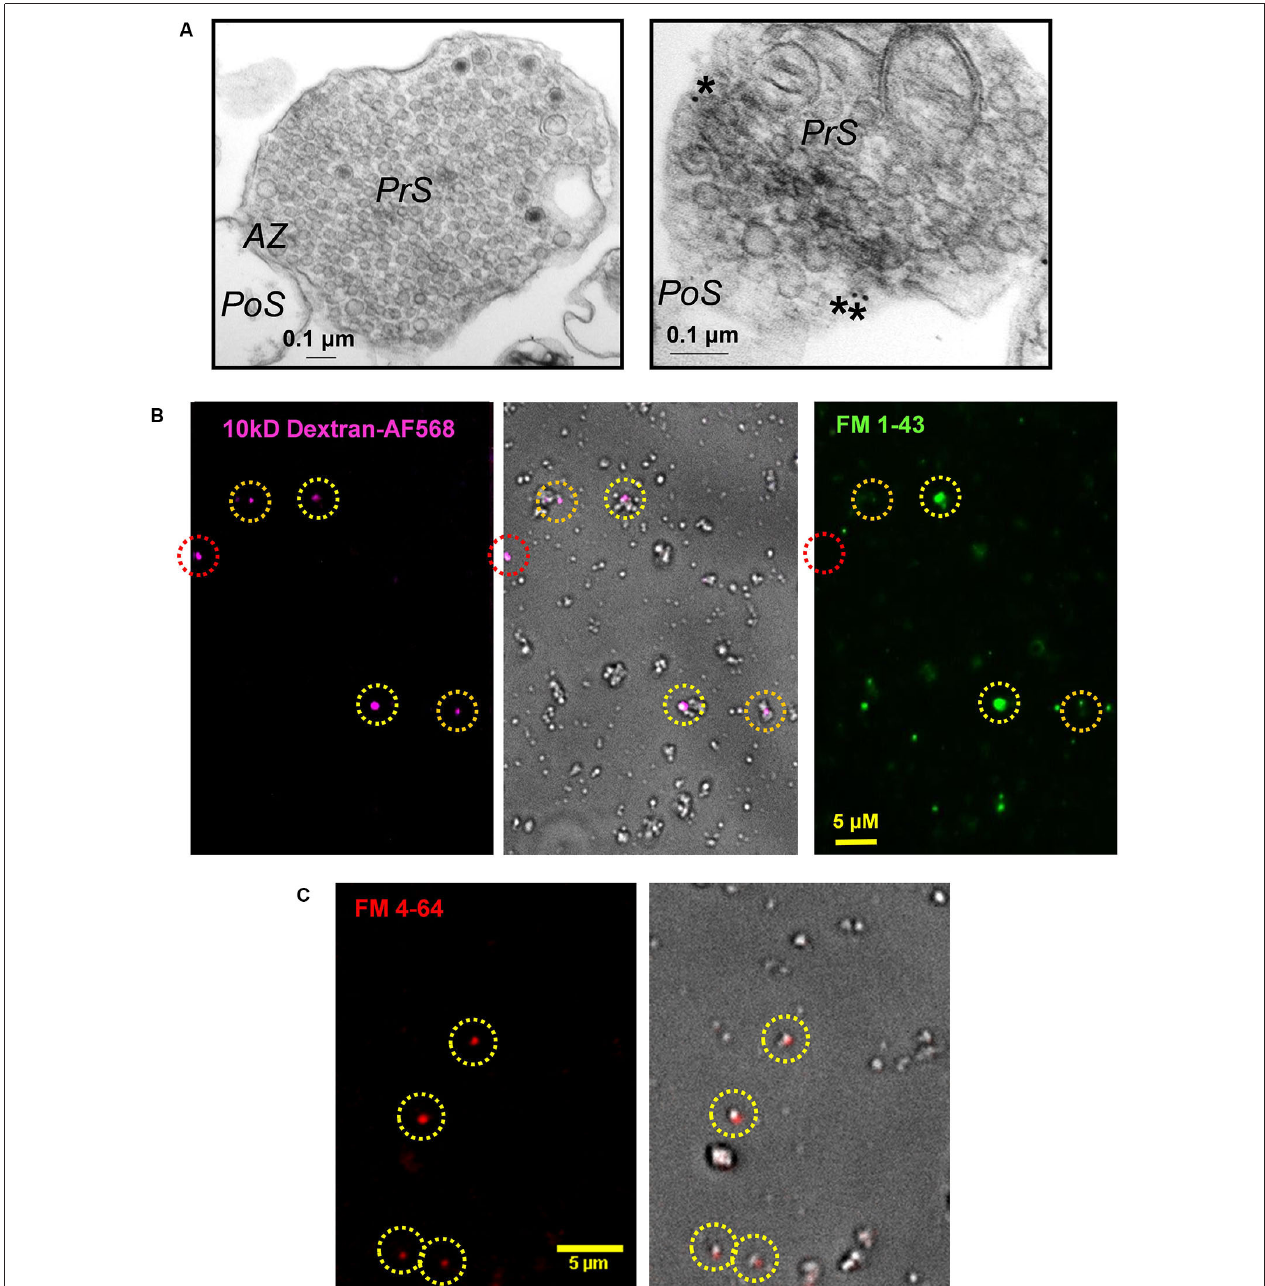
( yellow ), detectable ( orange ) or absent ( red ) FM dye staining. In control terminals the majority of cryoloaded SSMs exhibited at least detectable FM dye uptake ( see text ). (C) Dye uptake is retained through the cryoloading procedure. FM4-64 uptake was performed on fresh SSMs that were then subjected to the freeze-thaw cycle prior to mounting on a coverslip and imaging. The circled SSMs retained styryl dye staining ( left panel , bright field overlay, right panel ), indicating that recycled SVs survive the cryoloading procedure.